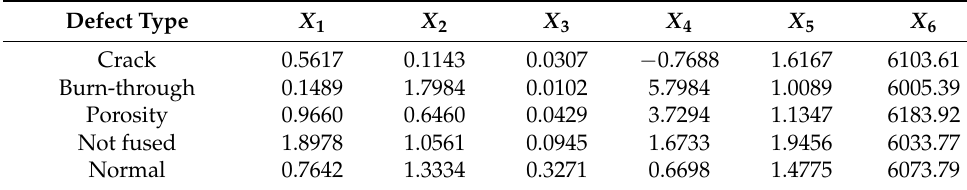
Table 4. Standard sample parameter values.